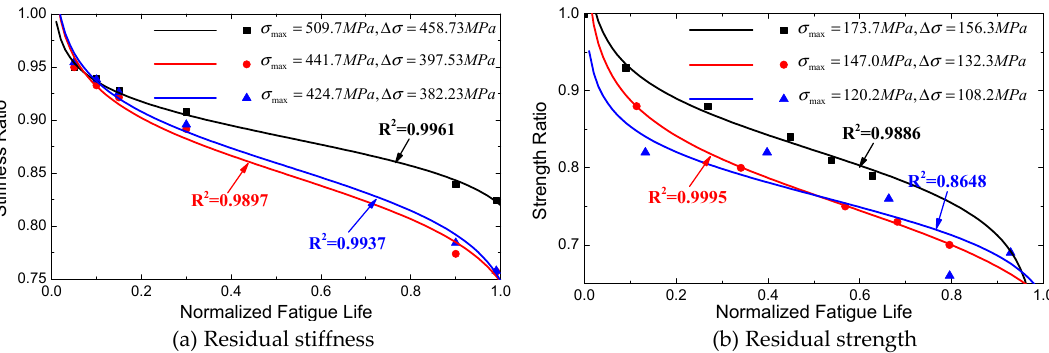
Figure 8. Mechanical property degradations of composite materials under different stress levels: ( a ) residual stiffness, ( b ) residual strength.